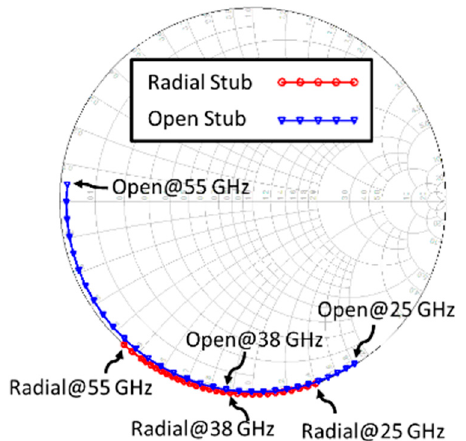
Figure 5. Comparison of impedance variation between an open-stub and radial-stub.